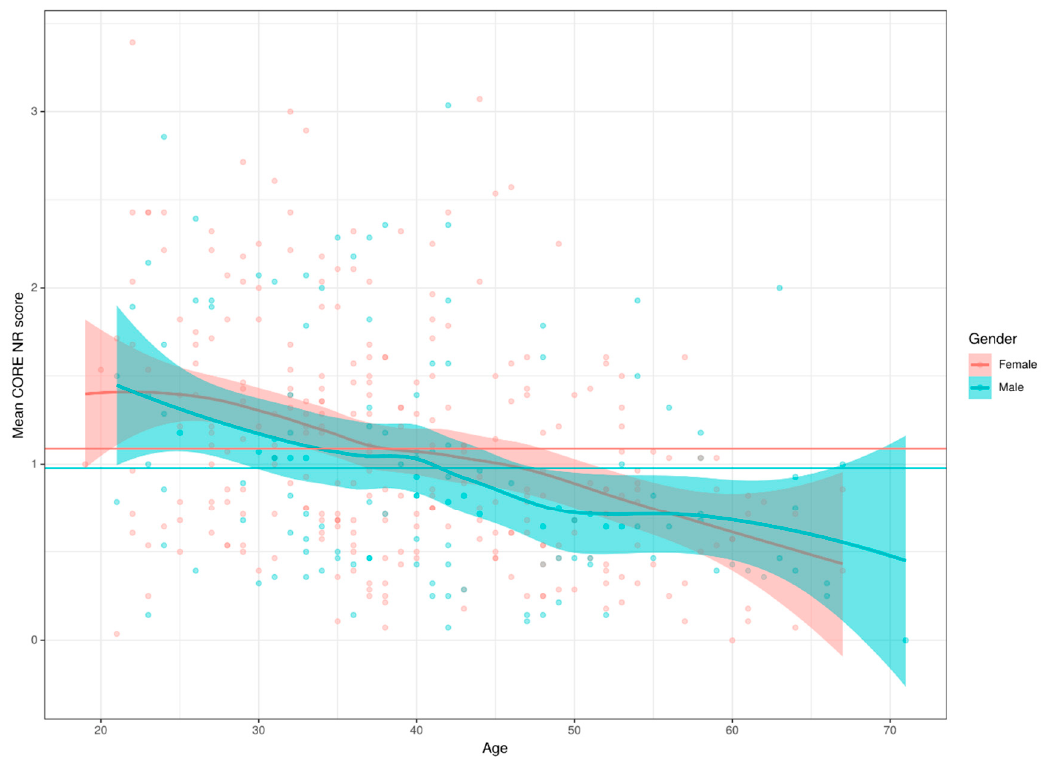
Figure 1. Relationship of CORE-OM NR score with age and gender. Int. J. Environ. Res. Public Health 2020 , 17 , x